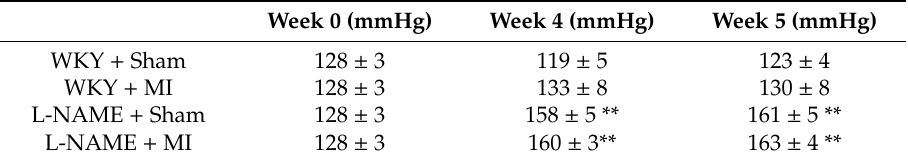
Table 1. Blood pressure of sham operated Wistar Kyoto rats (WKY + Sham); WKY rats with experimentally induced myocardial infarction (WKY + MI); sham operated WKY rats treated with L-NAME (20 mg / kg / day) (L-NAME + Sham) and L-NAME (20 mg / kg / day) treated WKY rats with experimentally induced myocardial infarction (L-NAME + MI). Week 0 - before treatment; Week 4 – four weeks L-NAME administration and before myocardial infarction, Week 5 – seven days after myocardial infarction; ** p < 0.01 compared to WKY + Sham; N = 6 in each group. Week 0 (mmHg)